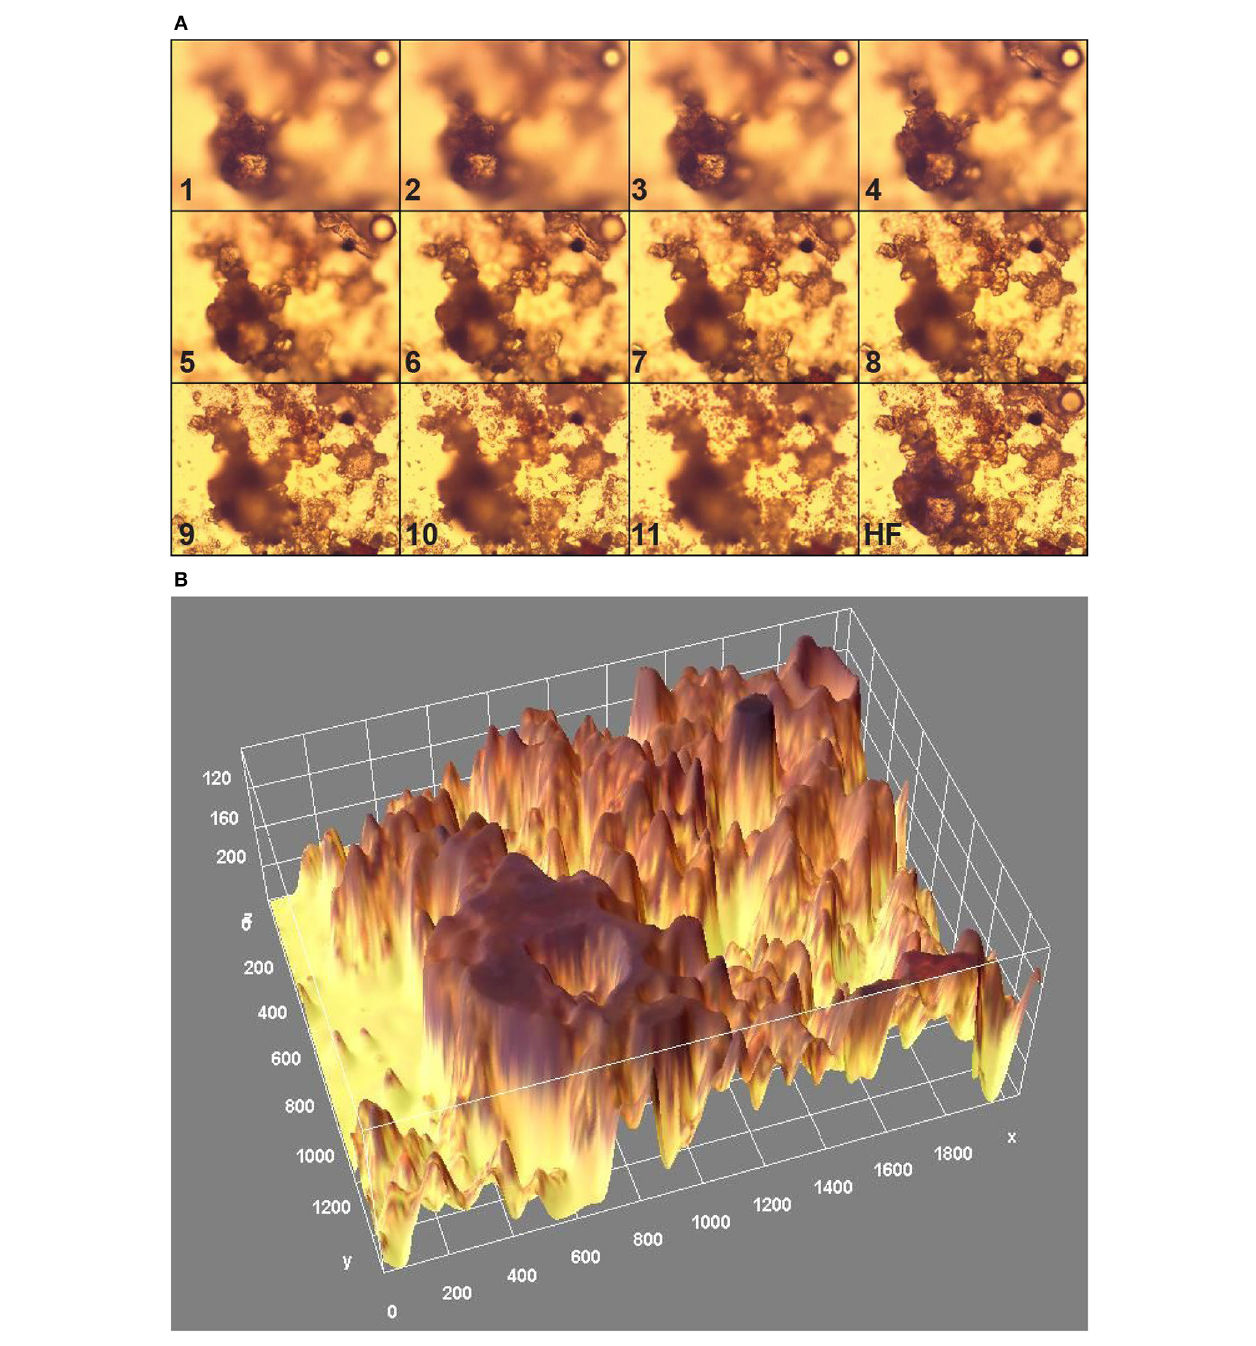
FIGURE 6 | Optical confocal microscopy sections through a marine biofilm on glass: (A) stock of sections from (1) to (11) spitted to (HR) with Helicon Focus routine; z-axis separation = 3 µ m, (B) 3D reconstructed surface architecture with ImageJ program from HF covering area = 425 × 570 µ m (Magnification = 400 times; x, y, and z axes in pixels i.e., 180 pixels = 50 µ